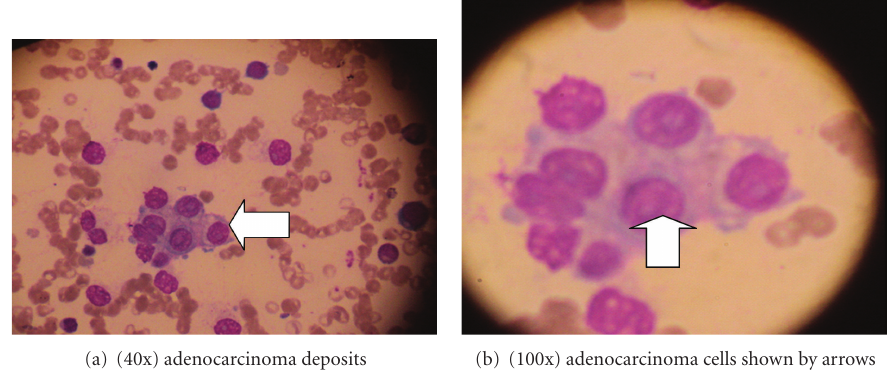
Figure 3: Bone marrow aspirate showing cells with round to oval nuclei and abundant pale eosinophilic and vacuolated cytoplasm.